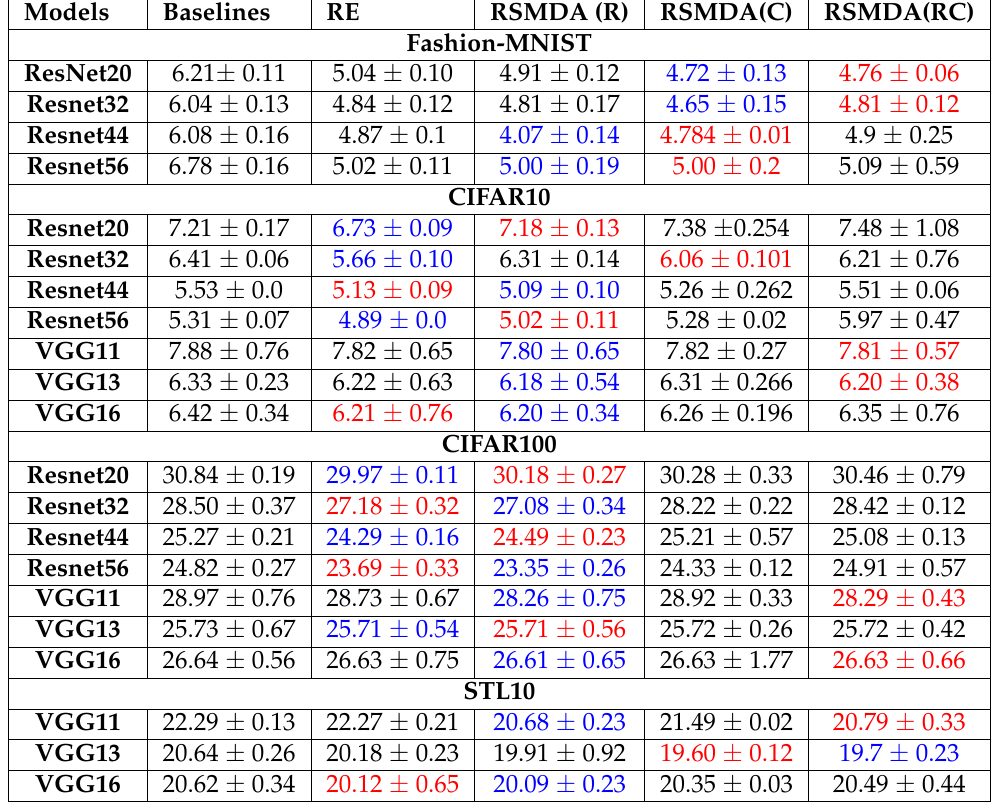
Table 1. Performance comparison of the proposed approach with random erasing and baseline. First best and second best performances are highlighted in blue and red color, respectively.